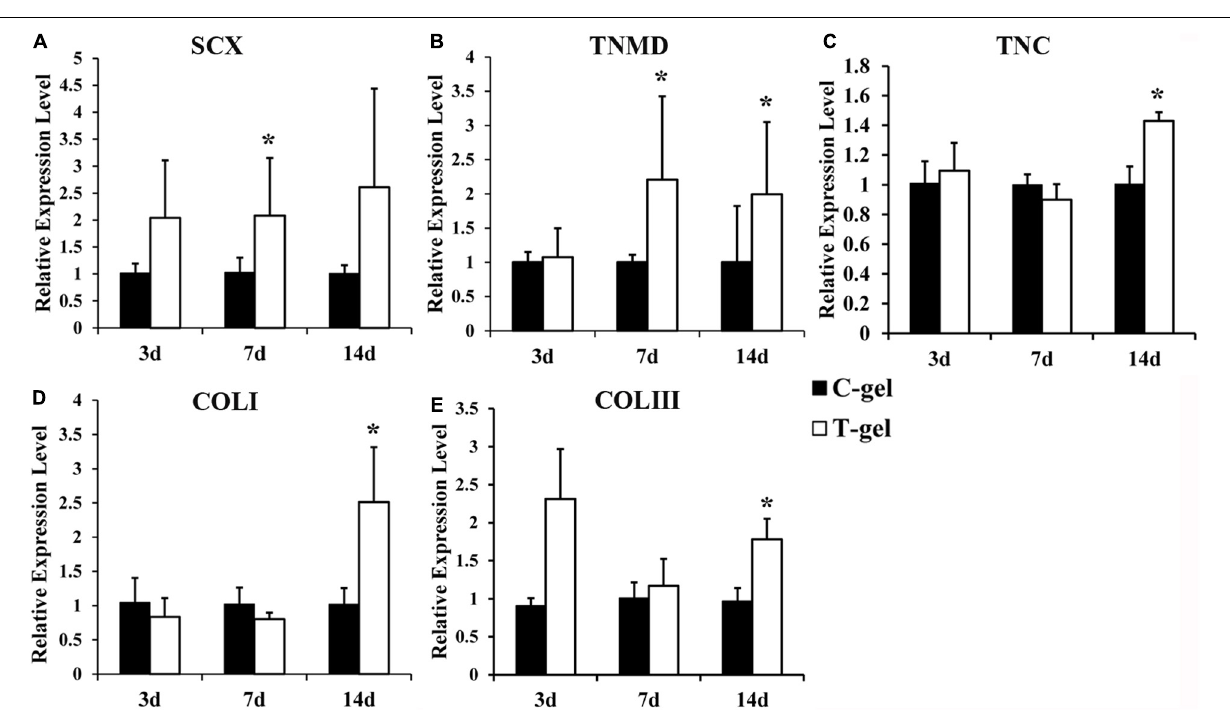
FIGURE 10 | Cell differentiation assays of the C-gel and T-gel. (A–E) RT-qPCR analysis of tendon-related gene expressions of the mTDSCs seeded on the C-gel and T-gel at different time points. Gene expression levels are normalized to the housekeeping gene, GAPDH. *Signifies a P- value of < 0.05 as compared to the